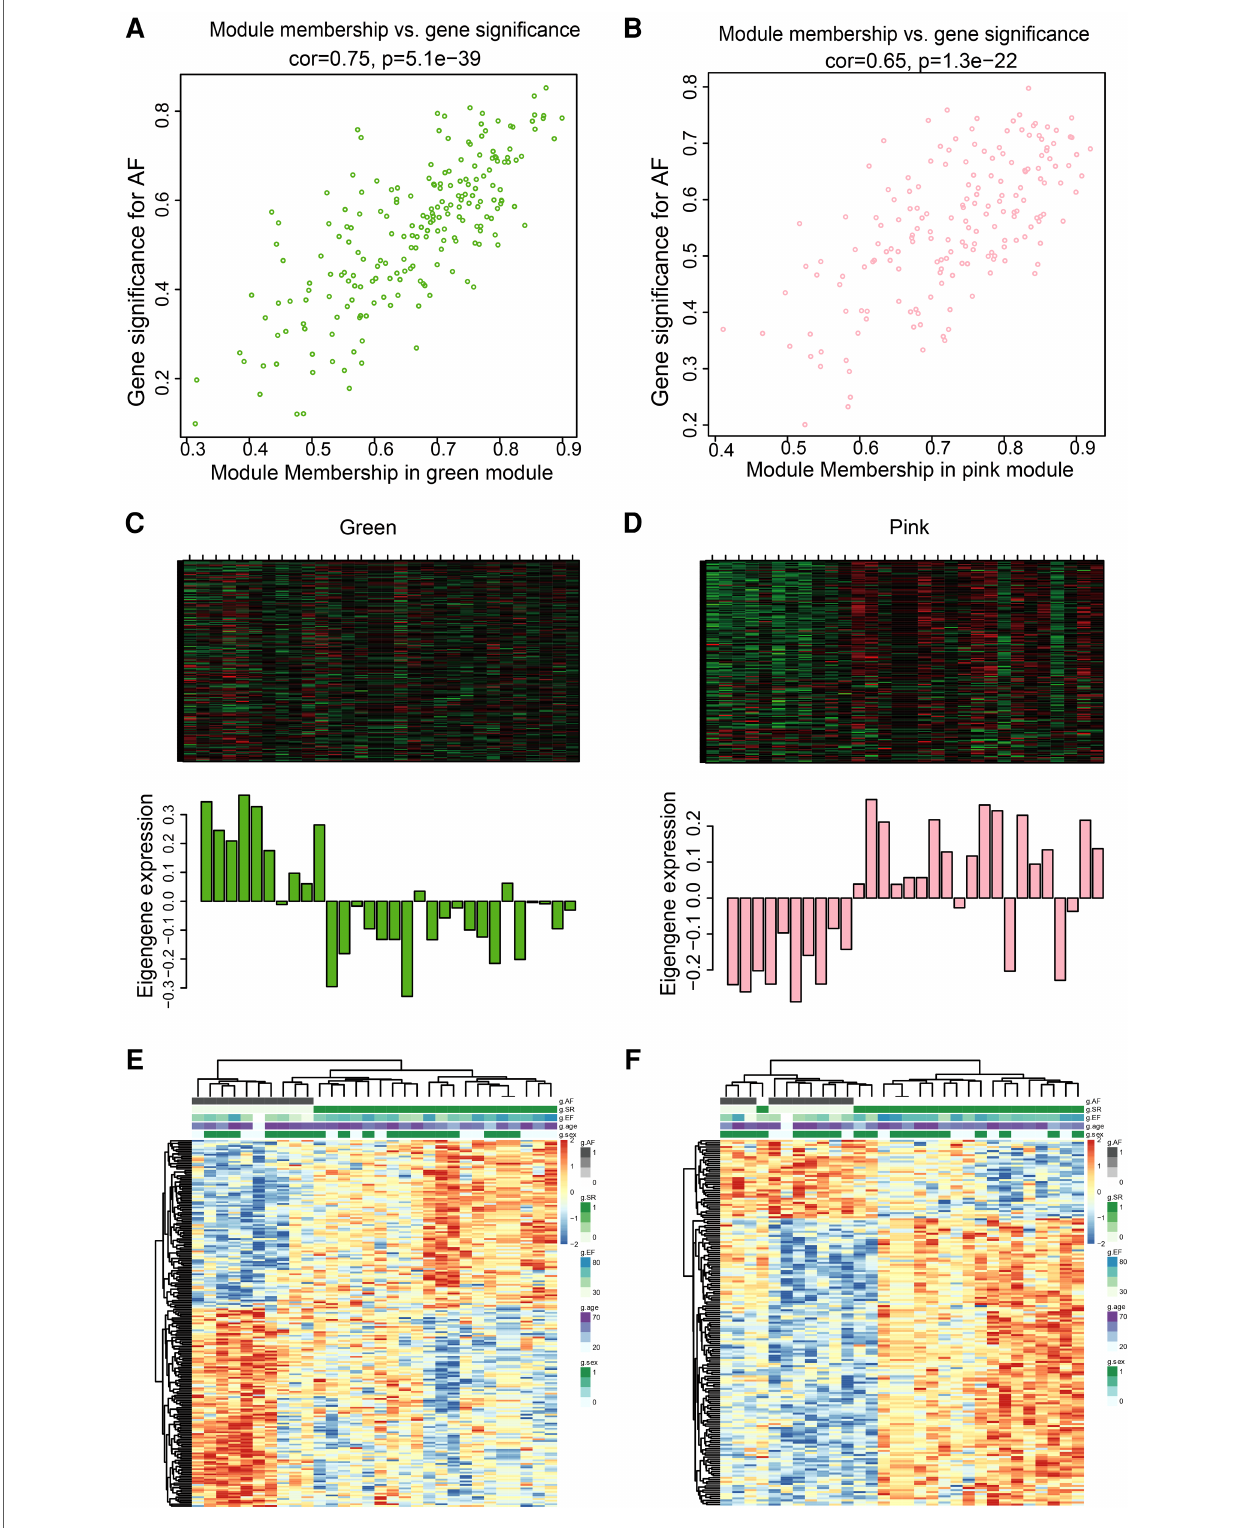
FIGURE 5 Correlation between green and pink modules with SR and AF. ( A,B ) Scatter plot in green ( A ) and pink ( B ) modules with GS ( y -axis) and MM ( x -axis). ( C,D ) The expression level of genes in green ( C ) and pink ( D ) modules. In the heatmap, green indicates the low expression and red indicates the high expression for samples. ( E,F ) Heatmap and clustering map of clinical traits in green ( E ) and pink ( F ) modules. In the clustering map, the varying shades of color recognizes low to high levels of expression in each clinical